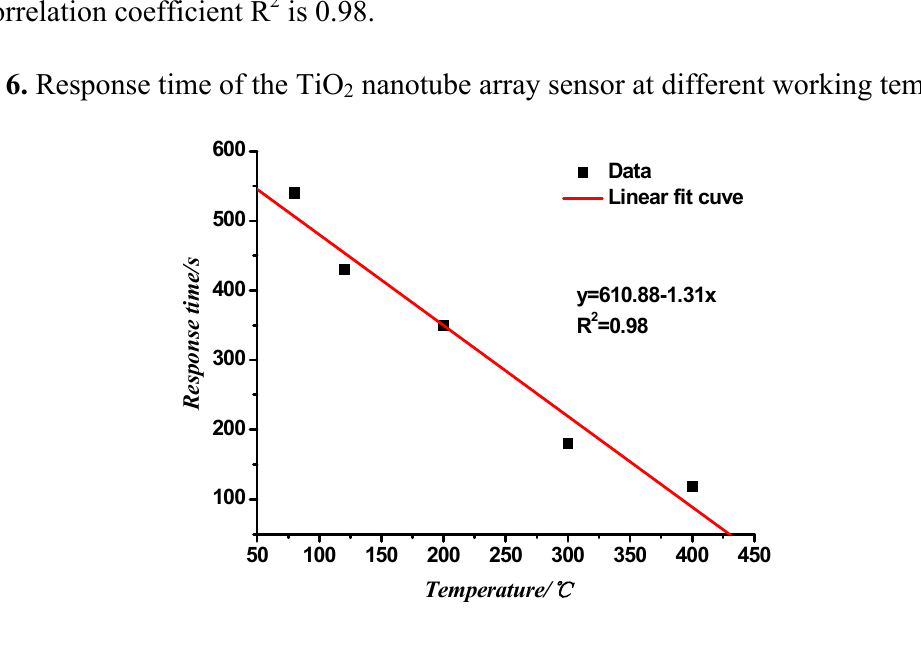
Figure 6. Response time of the TiO